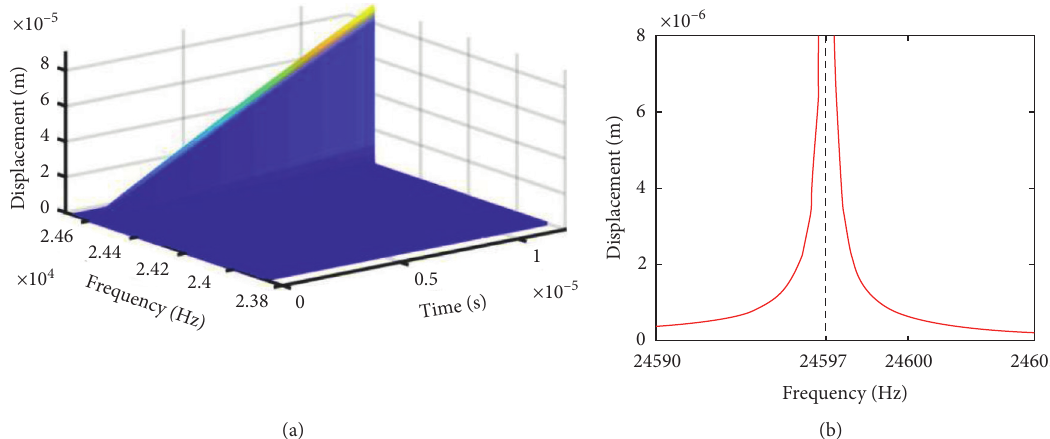
Figure 8: Amplitude-frequency characteristics of the difference solution: (a) there-dimensional diagram; (b) the amplitude-frequency characteristics.